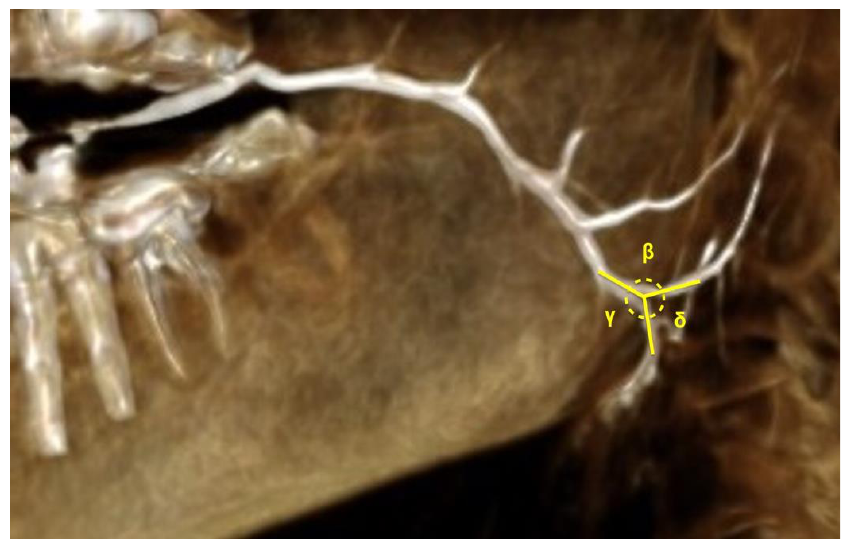
Figure 5. Angles between parotid duct and its tributaries after hilus. (β) Angle between parotid duct and superior parotid duct; (γ ) angle between parotid duct and inferior parotid duct; ( δ ) angle between superior and inferior parotid duct.